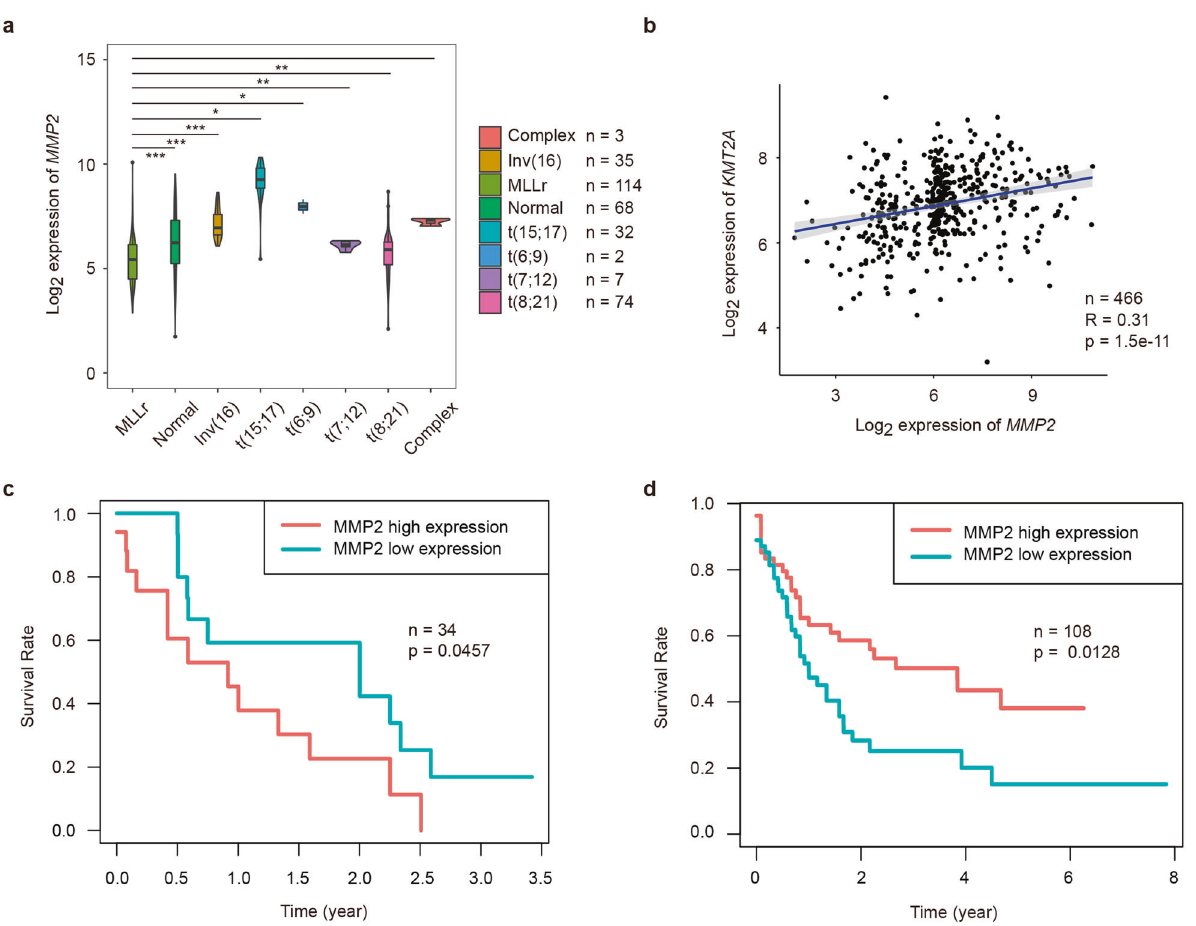
Fig. 5 Low expression of MMP2 indicates a better prognosis in AML patients with HU treatment. a MMP2 expression levels in primary AML patient samples carrying indicated mutations were shown by analyzing the publicly available microarray datasets. Wilcoxon rank-sum tests were performed. Sample size and P-values were presented. * for P < 0.05, ** for P < 0.01, *** for P < 0.001. b Co-expression correlations between MMP2 and KMT2A (MLL). c Kaplan-Meier survival curve of AML patients with HU treatment from the TCGA dataset (low expression: 50%, n = 17; high expression: 50%, n = 17). d Kaplan-Meier survival curve of AML patients without HU treatment (low expression: 50%, n = 54; high expression: 50%, n =